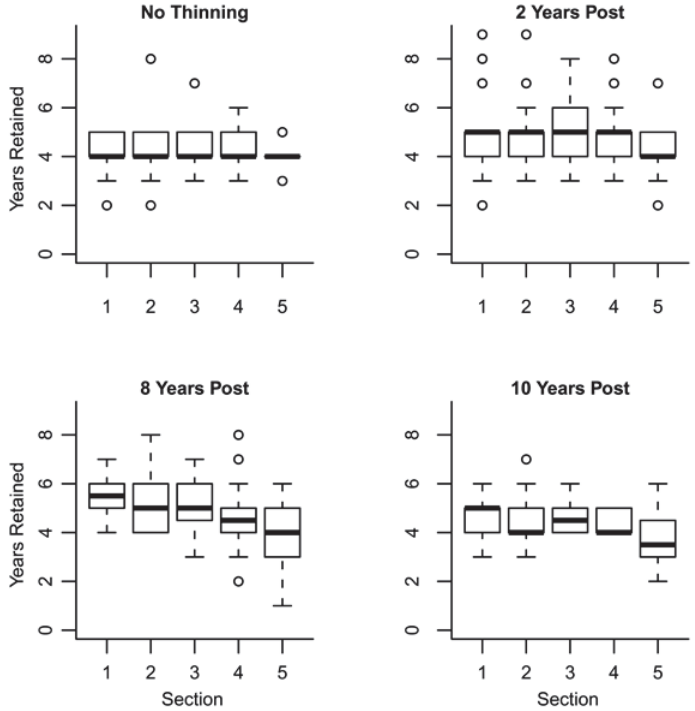
Figure 3. Box and whisker plots showing median, quartiles and the minimum and maximum years of needle retention by crown position, for branches sampled in unthinned and thinned areas by years since treatment.